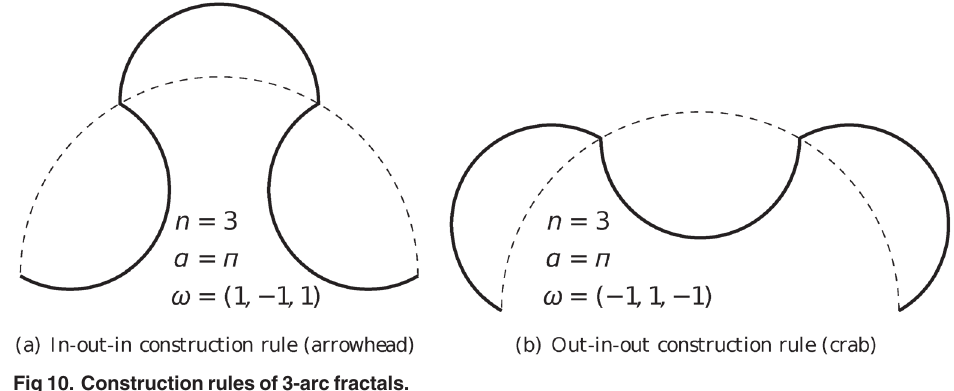
Fig 10. Construction rules of 3-arc